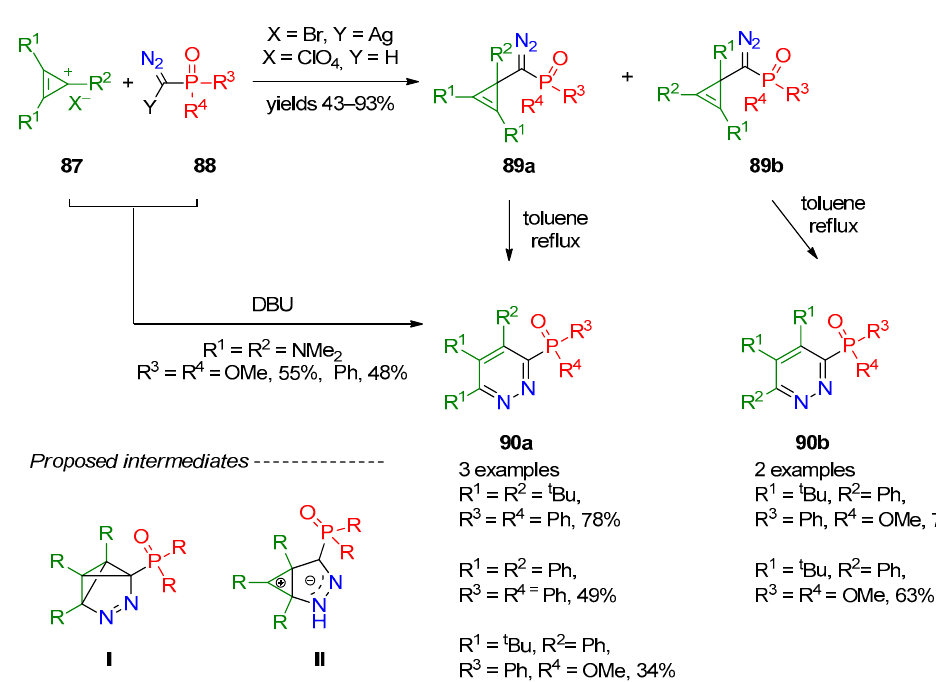
Figure 2. Approaches to synthesis of POR 2 -containing pyridazines.